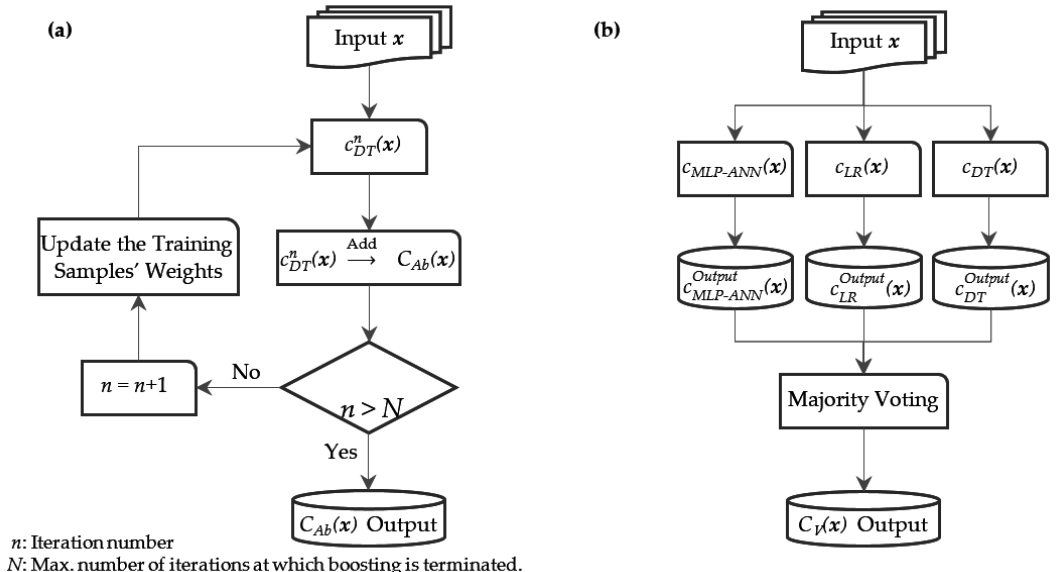
( x ) and C ( x ) represent the DT Ab DT